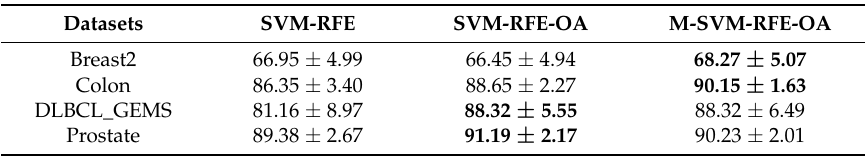
Bold: the largest value in a dataset among the three methods. Table 3. Comparison in sensitivity (%).